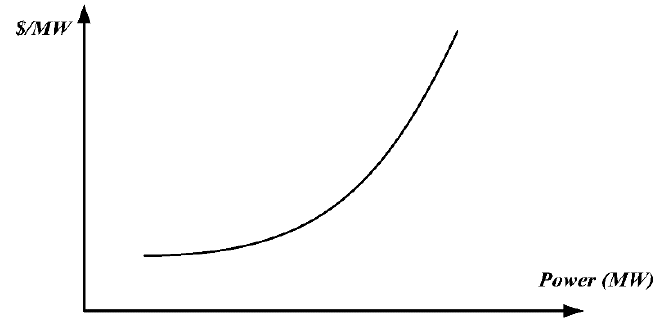
Figure 1. Fuel cost curve for simple Power Economic Dispatch (PED) problem.